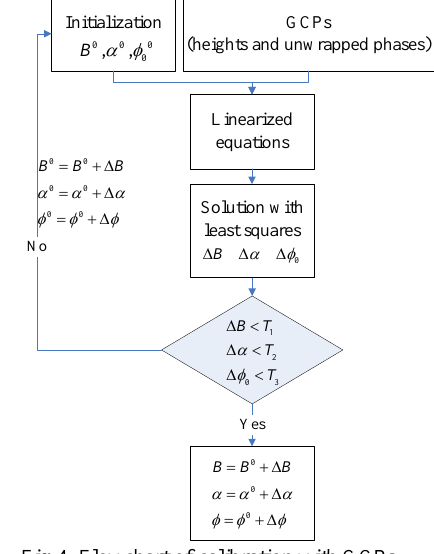
Fig.4. Flowchart of calibration with GCPs The calibration flowchart with GCPs in a block is shown in Fig.4. , , T T T are the thresholds for deciding whether to iterate. Where, 1 2 3 It needs lots of GCPs to obtain accurate interferometric parameters in a large area if only adopting GCPs to estimate interferometric parameters, for it needs at least 3 GCPs in each block. In order to illuminate the issue, Fig.5 is used, which includes two passes of interferometric SAR data. If the baselines parameters and phase offsets of the two passes are estimated by single pass baseline estimation method, which only uses the GCPs covered in corresponding image, more than 3 GCPs are needed because each pass needs at least 3 GCPs. The more passes, the more GCPs are needed.